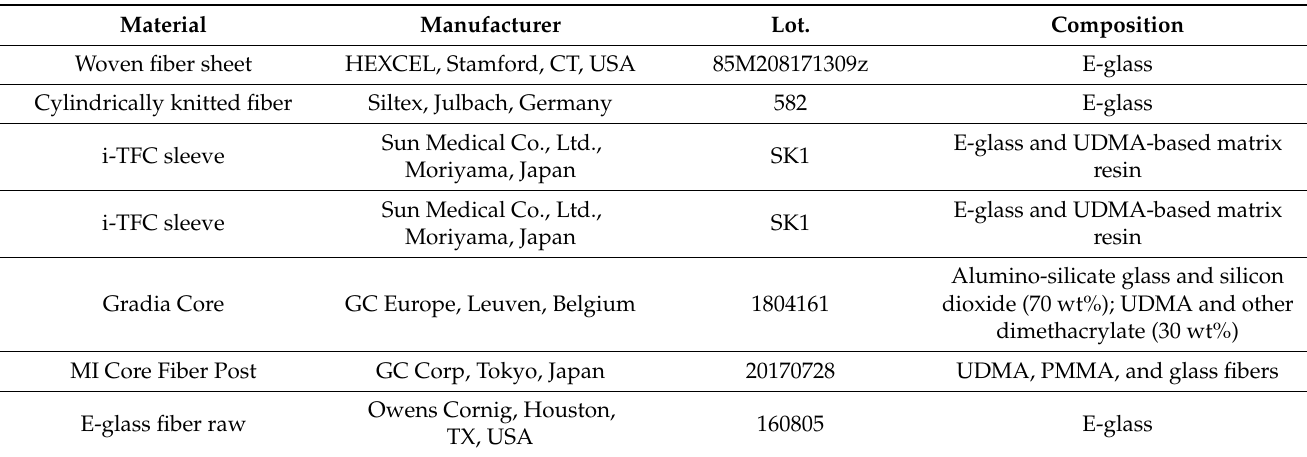
Table 1. Materials used in this